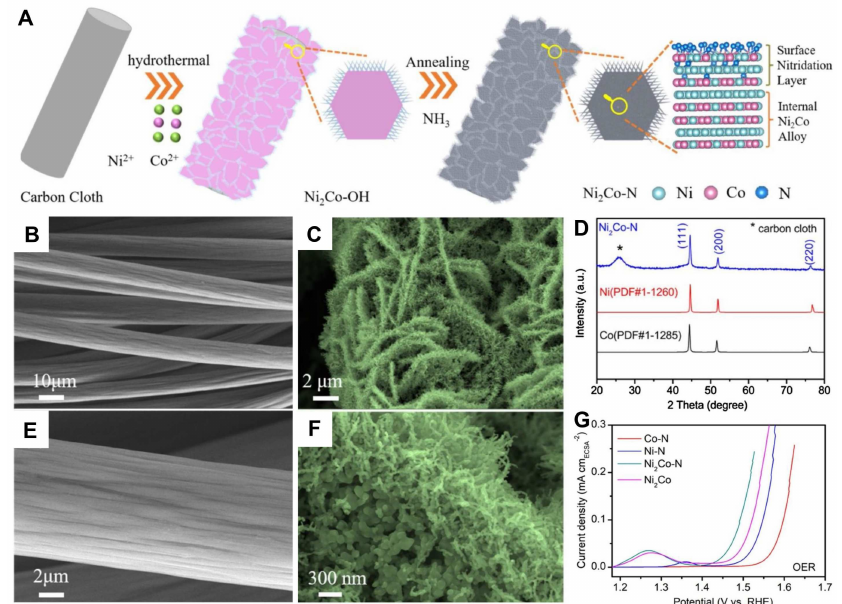
Figure 5. ( A ) Schematic illustration of the formation of Ni 2 Co-N nanocactoids grown on carbon cloth; SEM images of ( B , C ) bare carbon cloth; ( D , E ) Ni 2 Co-N; ( F ) XRD pattern of Ni 2 Co-N; ( G ) LSV curves of different electrocatalysts in 0.1 M KOH electrolyte. Reproduced with permission from